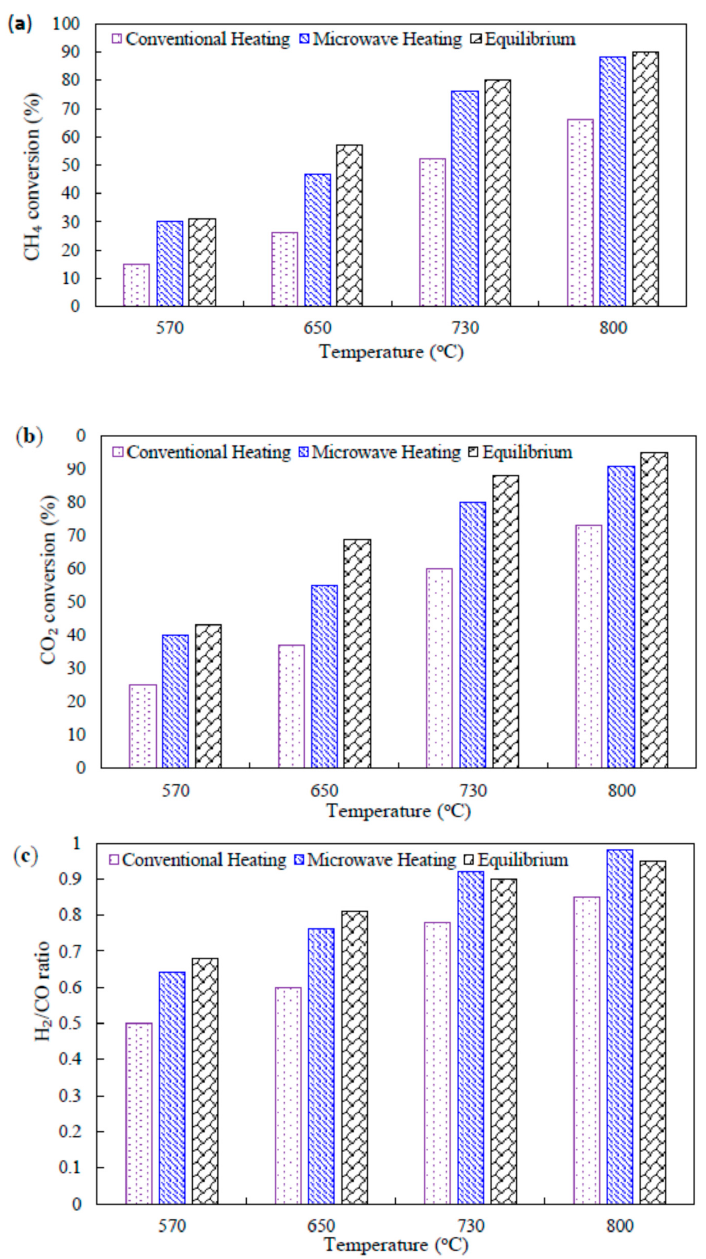
Figure 3. ( a ) CO ₂ and ( b ) CH ₄ conversions and ( c ) product selectivity as a function of temperature over the prepared catalysts using microwave heating.